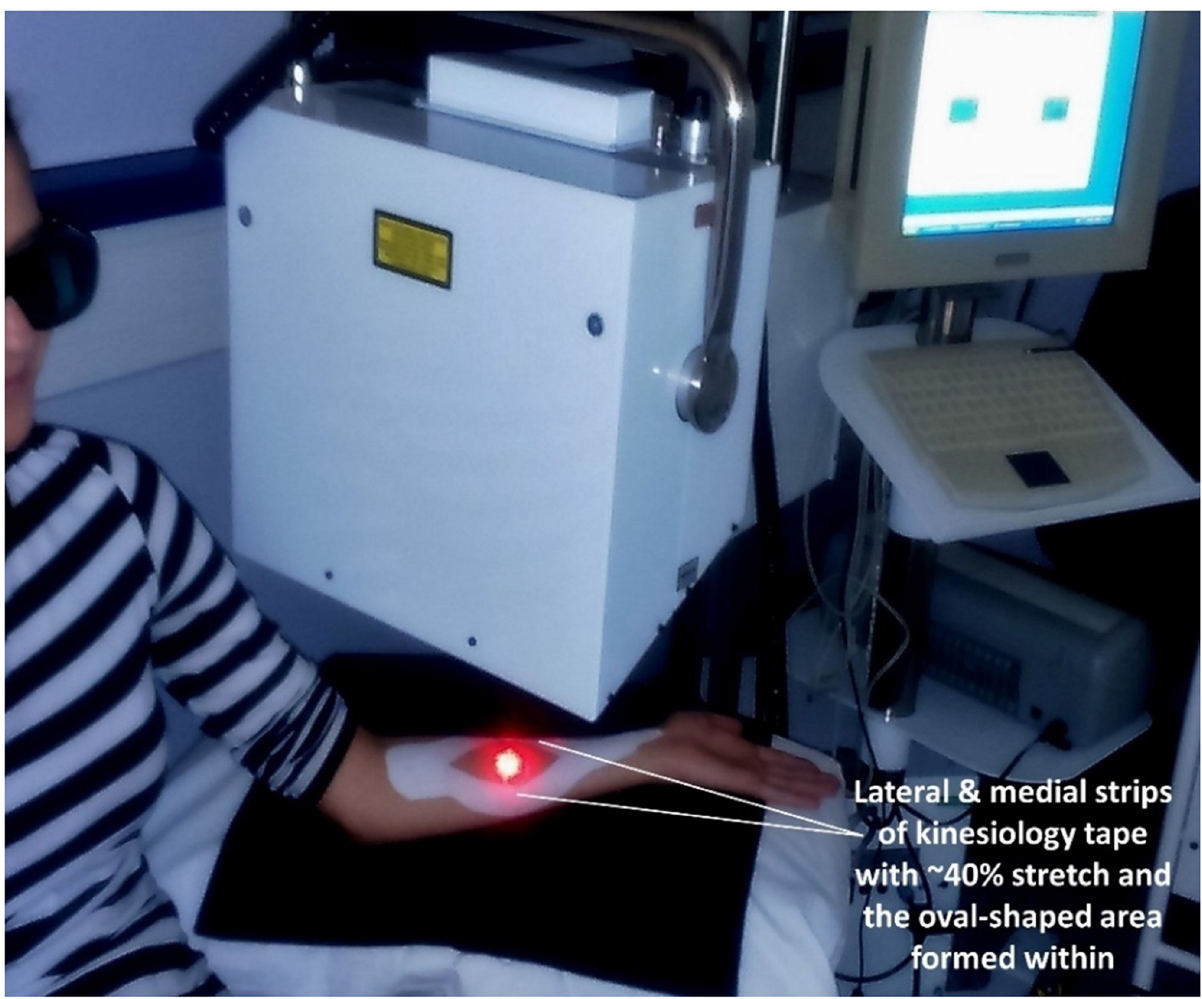
Fig 2. Demonstration of laser Doppler imaging of the oval-shaped site of testing formed by the inner margins of lateral and medial strips of tape.